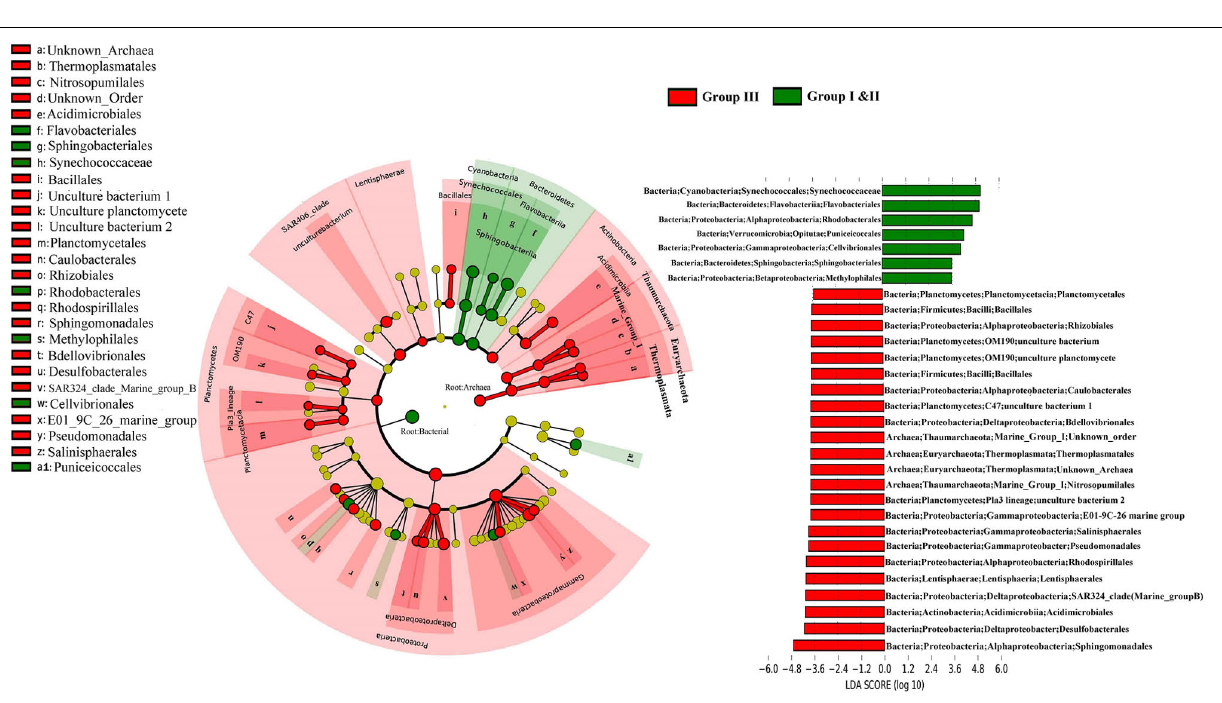
FIGURE 4 | The cladogram indicates the phylogenetic distribution of the microbial lineages in the surface and deep water. The average abundance of microbial taxa in two groups was used in the differential analysis. The LDA score of the taxa representing the odds of their distribution between surface and deep. The phylum, class and order are listed in order from the inside to the outside of each